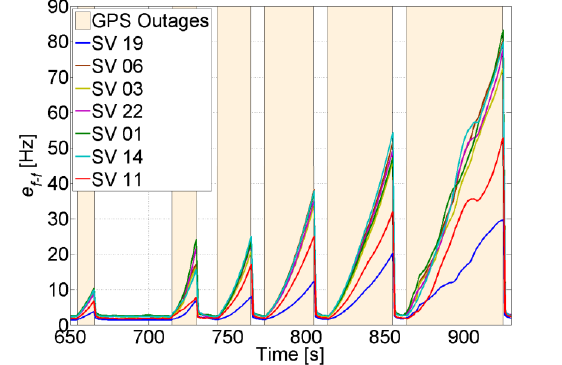
Figure 23. Feed-forward frequency uncertainty during GPS total